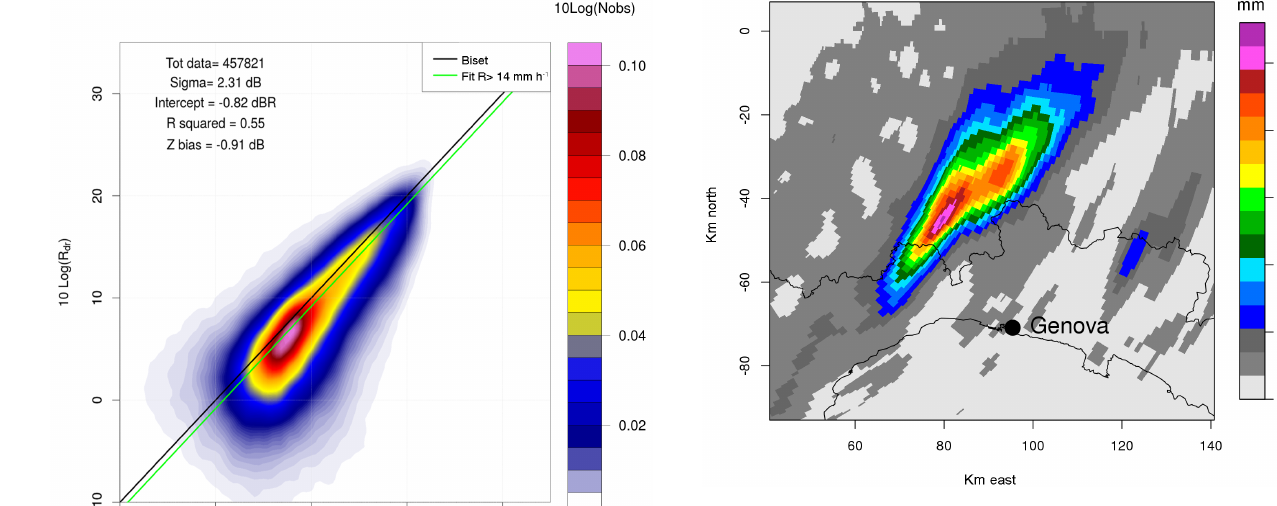
Figure 8. 24h cumulative precipitation in millimeters (color scale) from the Bric della Croce radar on 13 October 2014. The axes dis- play the east and north distances from the radar. The black point refers to the city of